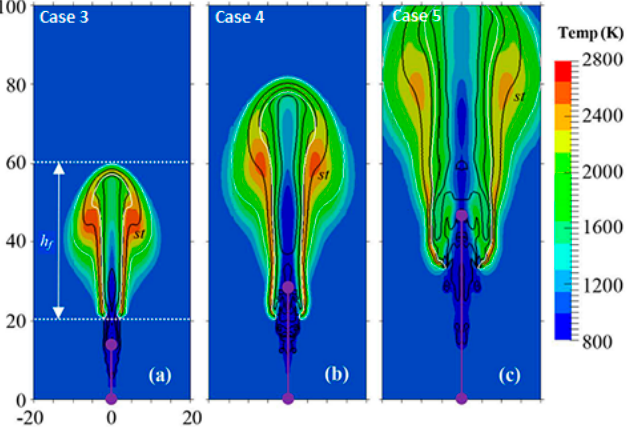
Figure 32. Comparisons of temperature distributions of the established flames for nozzle diameters of ( a ) 100 µm, ( b ) 180 µm, and ( c ) 363 µm. The temperature contours, equivalence ratio iso-contours (black lines), and OH mass fraction iso-contours (white lines) are reflected along the spray axis, while the purple solid lines represent the averaged LPL (liquid penetration length) in the reacting cases [38].